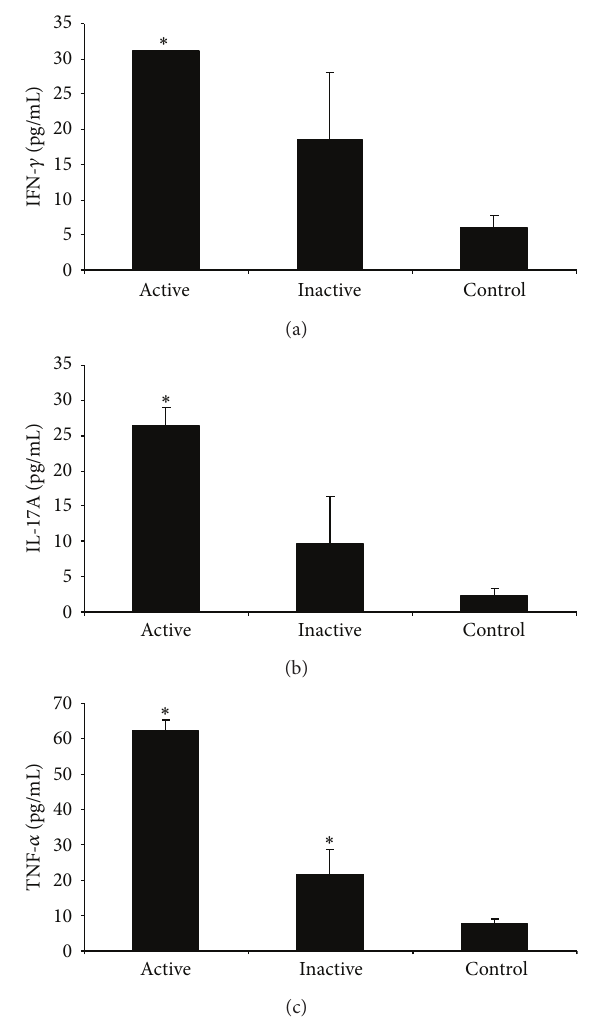
Figure 3: Circulating levels of IFN- 𝛾 , IL-17A, and TNF- 𝛼 in patients with active BD ( 𝑁 = 3 ) and inactive BD ( 𝑁 = 13 ) without treatment and control subjects ( 𝑁 = 20 ). Results are expressed as mean values of cytokine levels (pg/mL) ± SEM. Statistical analysis was performed by Kruskal-Wallis test ( ∗ 𝑃 < 0.05